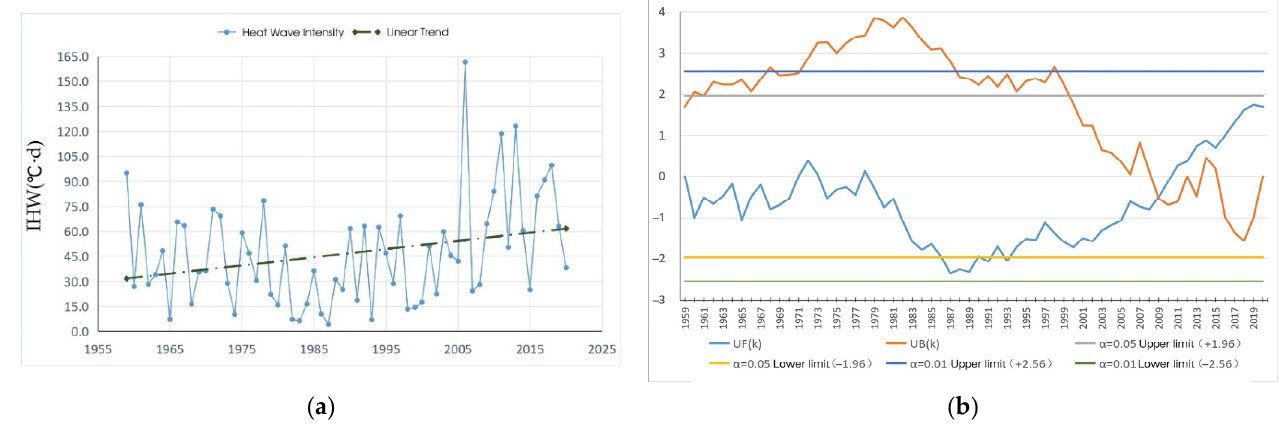
Figure 4. Historical changes in the IHW in Chongqing from 1959 to 2020 and M-K test curves; ( a ) changes in IHW; ( b ) M-K test curves.